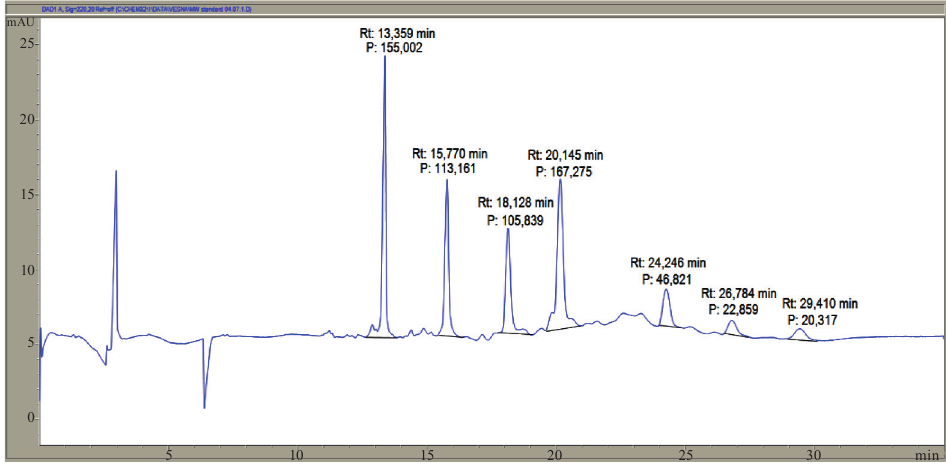
Figure 1 Electrophoregram of MW standards of proteins of known molecular weight separated by capillary gel electrophoresis